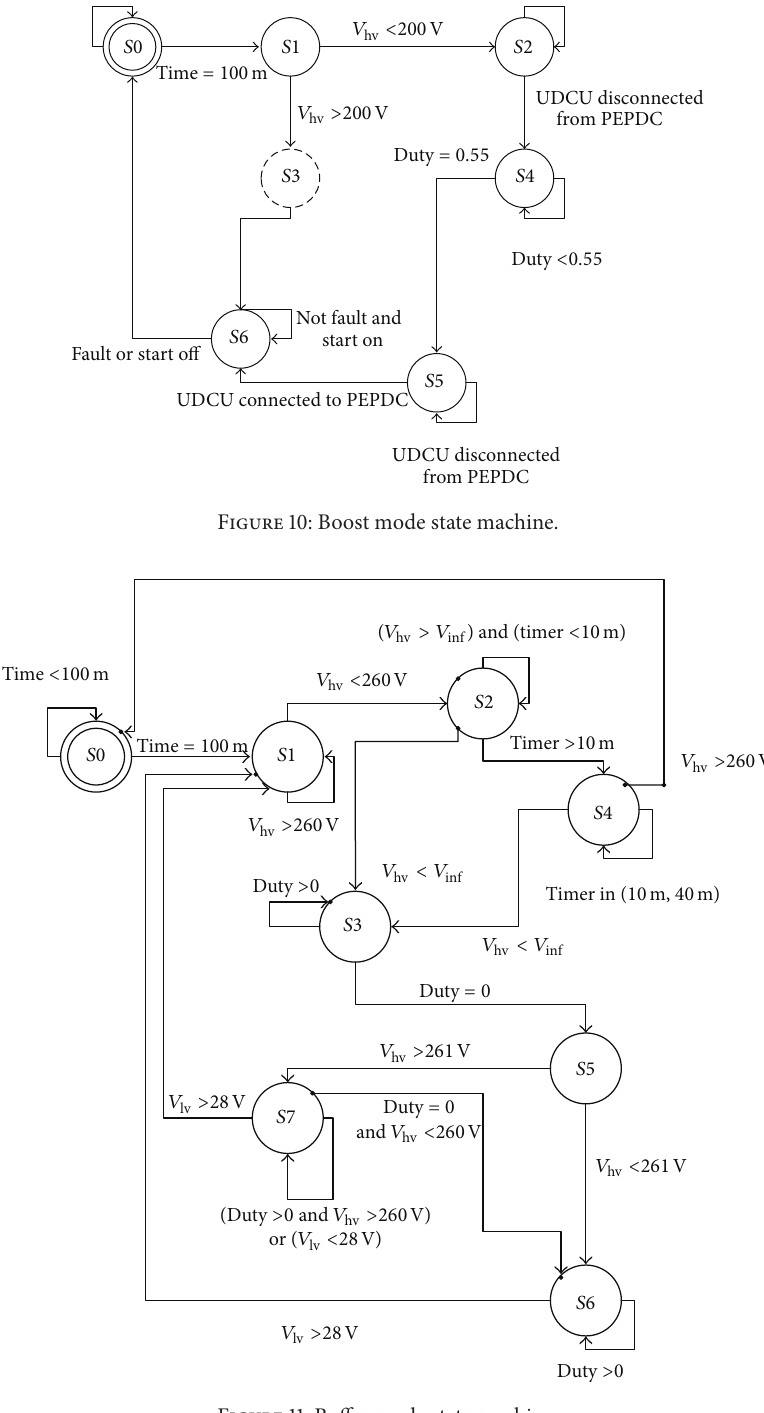
Figure 11: Buffer mode state